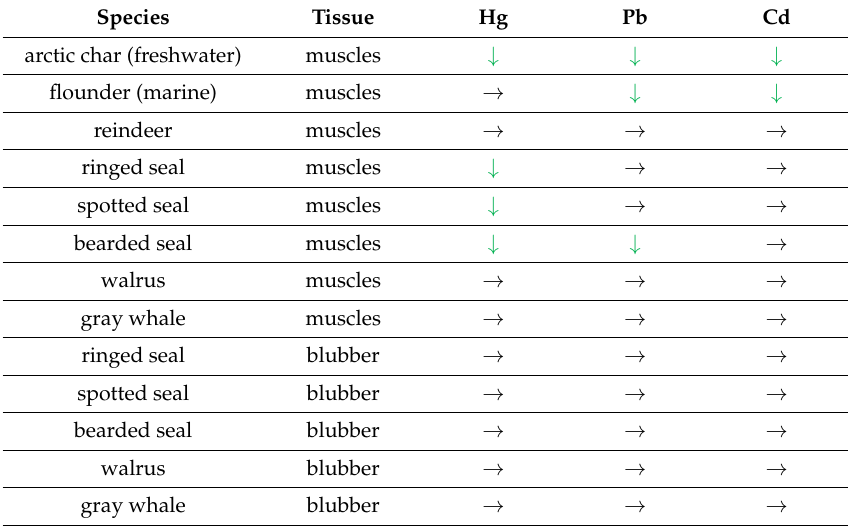
green arrows down = decrease; black arrows flat = no